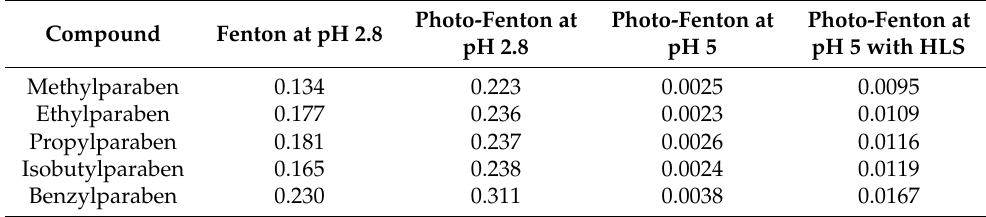
Table 1. Pseudo-first-order kinetic constants of parabens by Fenton and photo-Fenton degradation processes expressed in min − 1